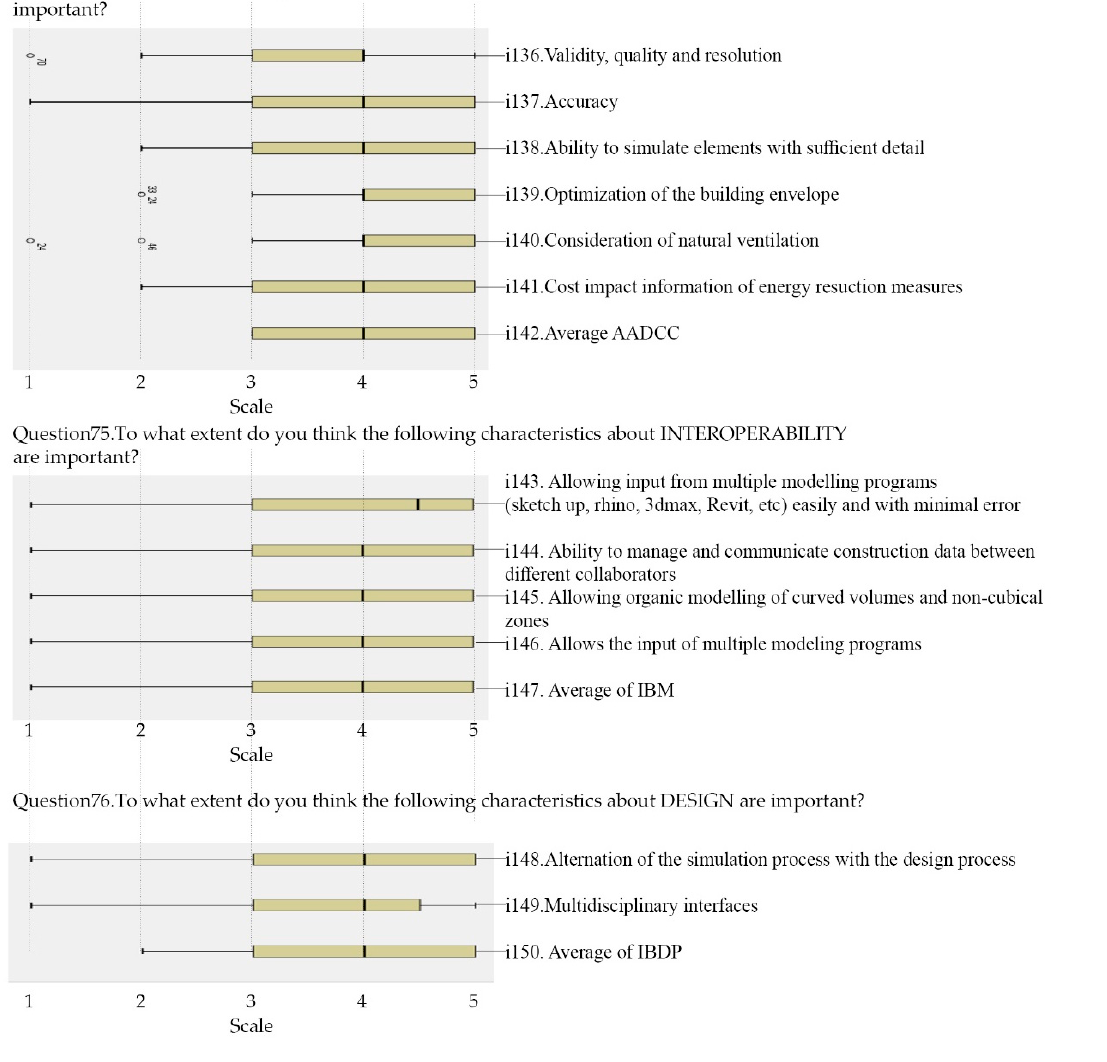
Figure 8. Relevant parameters and characteristics that lead to select BPSTs in Spain. The respondents have evaluated the following tools: UIM, IIKB, AADCC, IBM and IBDP. Scale 1 (little) to 5 (much). A Cronbach’s Alpha greater than 0.9 is excellent (0.97).